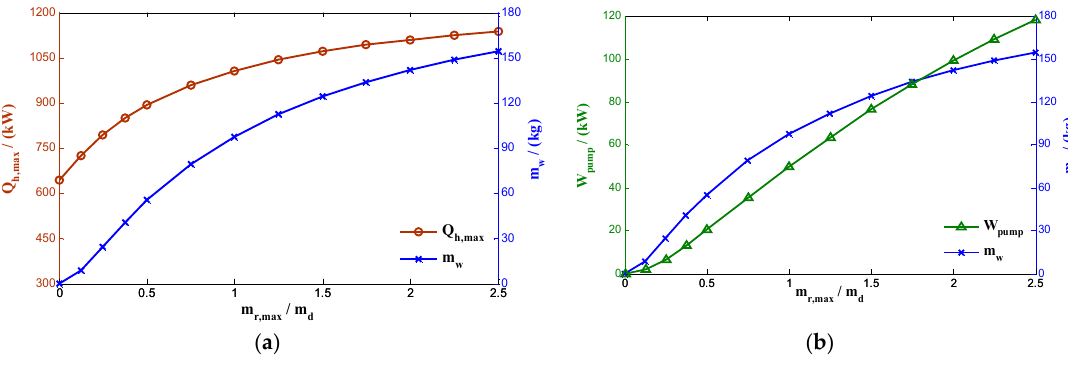
. Q  / m m   . . m r ,max / m d on Q h ,max , W pump and m w . ( a ) r d on ,max h , W pump and m w . ( a ) ,max r d